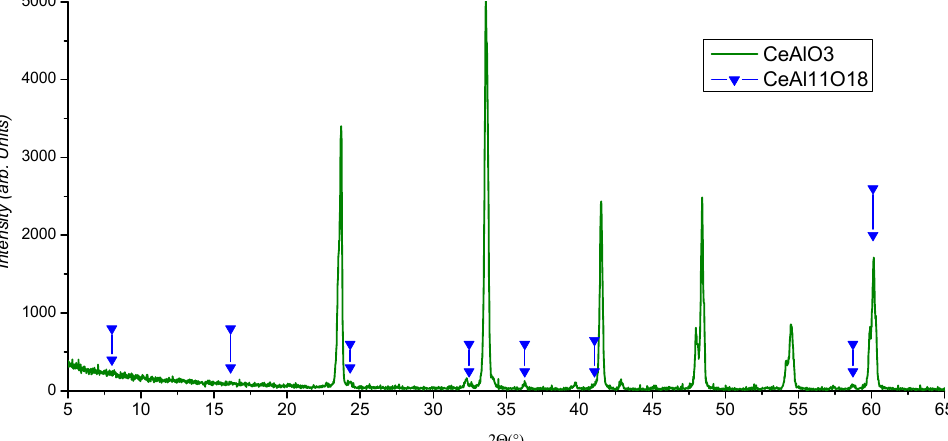
Figure 2. Photos of as-grown crystal ( a ), its transversal cut ( b ), and the same transversal cut under illumination with UV light ( c ).